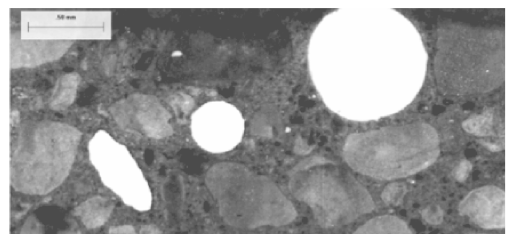
Fig. 4. Air void in non air-entrained SCC, w/b = 0.35. Scale on the figure means 0.5 mm (Szwabowski, Łaźniewska-Piekarczyk 2008)